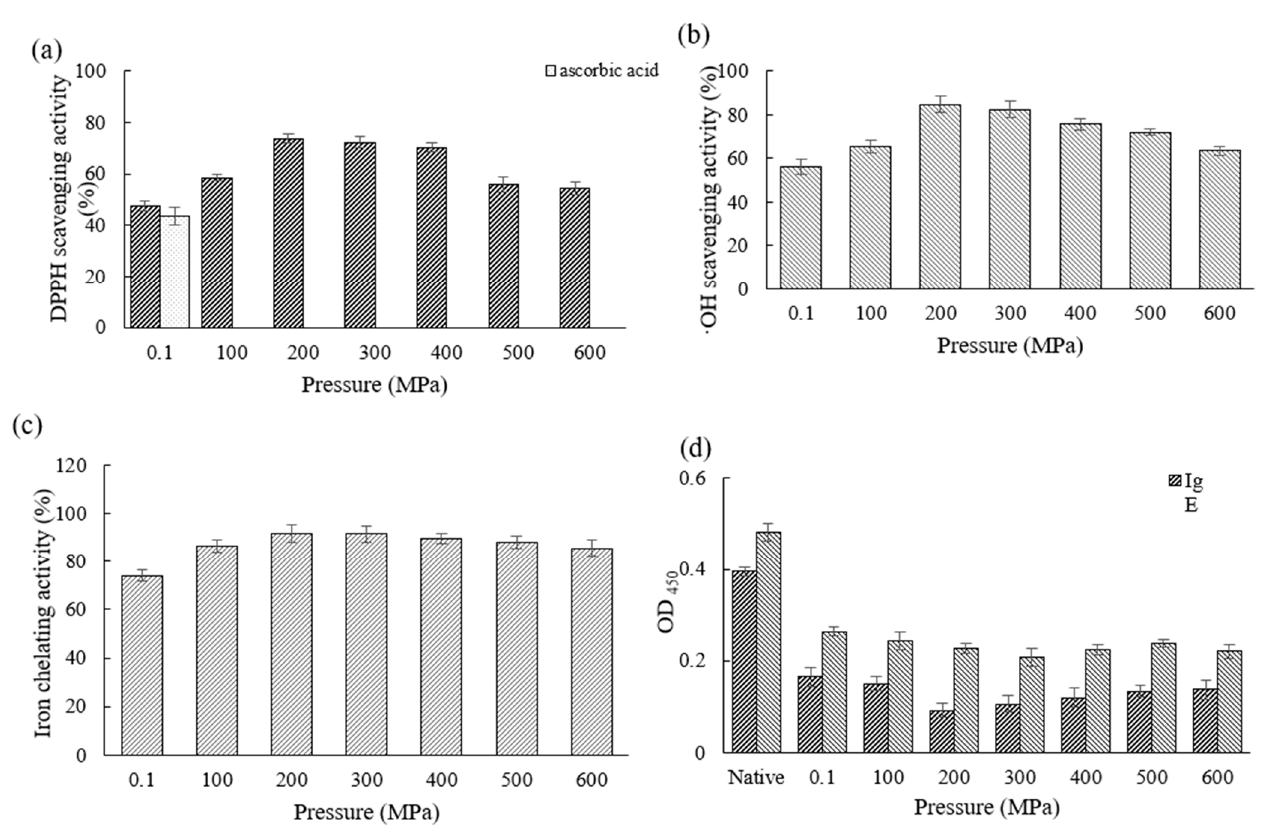
Figure 5. The antioxidant activities of hydrolysates produced under different pressures. ( a ) The DPPH scavenging activity of b-LG hydrolysates, ( b ) The · OH scavenging activity of b-LG hydrolysates, ( c ) The ion chelating activity of b-LG hydrolysates, and ( d ) The OD value at 450 nm of IgE/IgG-b-LG hydrolysates after HHP treatment.